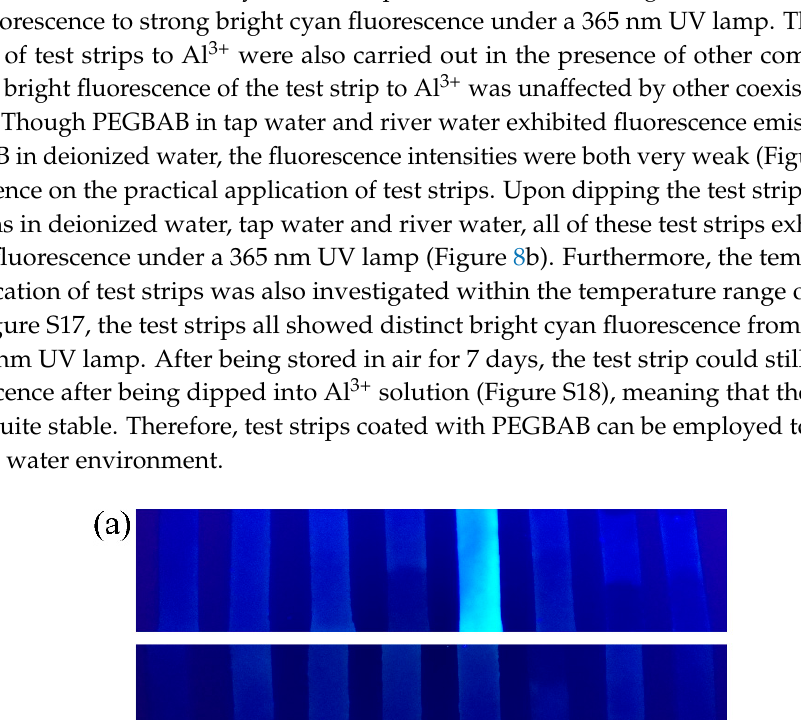
Figure S1: 1 H NMR spectrum of BAB in DMSO- d 6 ; Figure S2: 13 C NMR spectrum of BAB in DMSO- d 6 ; Figure S3: ESI-MS spectrum of BAB; Figure S4: 1 H NMR spectrum of PEGBAB in CDCl 3 ; Figure S5: 13 C NMR spectrum of PEGBAB in CDCl 3 ; Figure S6: UV-Vis absorption spectra of PEGBAB (10 µ M) with 2 equiv. of various metal Figure S6: UV-Vis absorption spectra of PEGBAB (10 μ M) with 2 equiv. of various metal ions in pure aqueous solutions; Figure S7: Benesi-Hildebrand plot of PEGBAB (10 μ M) with Al 3+ from UV-Vis titration profile for determination of association constant; Figure S8: The photograph of PEGBAB (10 μ M) in aqueous solution with different concentrations of Al 3+ (from left to right: 0, 0.1, 0.25, 0.5, 1, 2, 5 equiv.) under a 365 nm UV lamp; Figure S9: Job's plot of PEGBAB and Al 3+ in aqueous solution. The total concentration of PEGBAB and Al 3+ is 10 μ M; Figure S10: Benesi-Hildebrand plot of PEGBAB (10 μ M) with Al 3+ from fluorescence titration profile for determination of association constant; Figure S11: The linear of fluorescence intensity and concentration of Al 3+